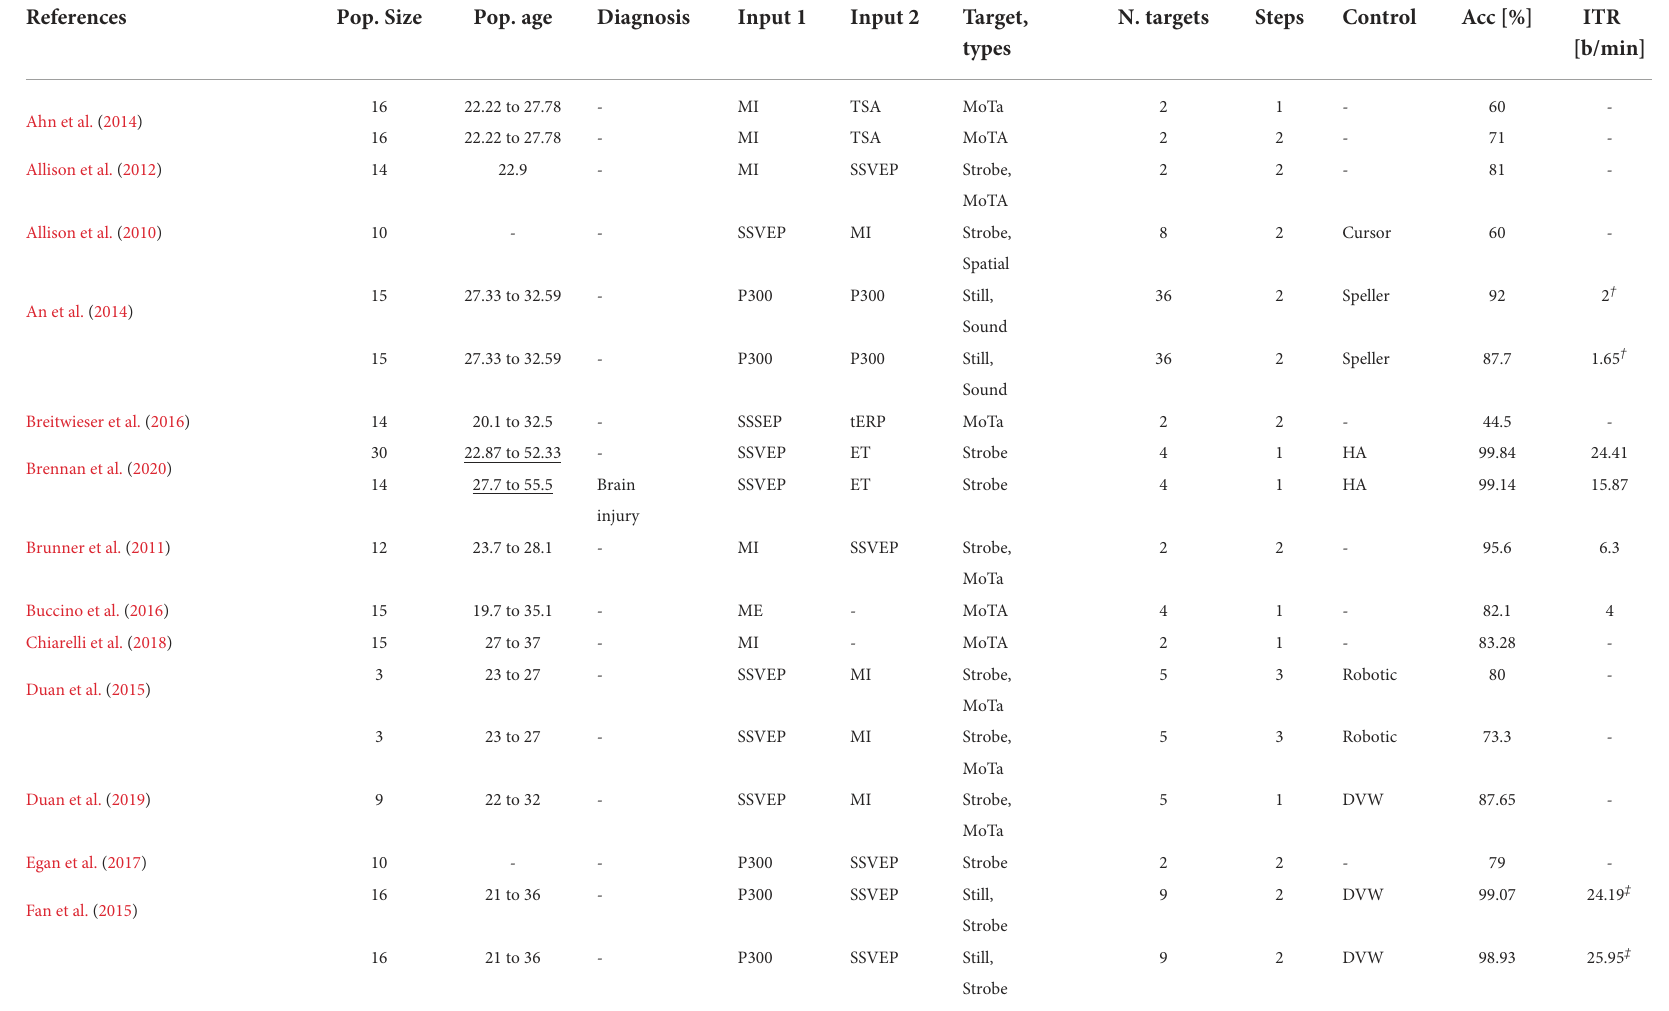
TABLE 2 Performance and interface